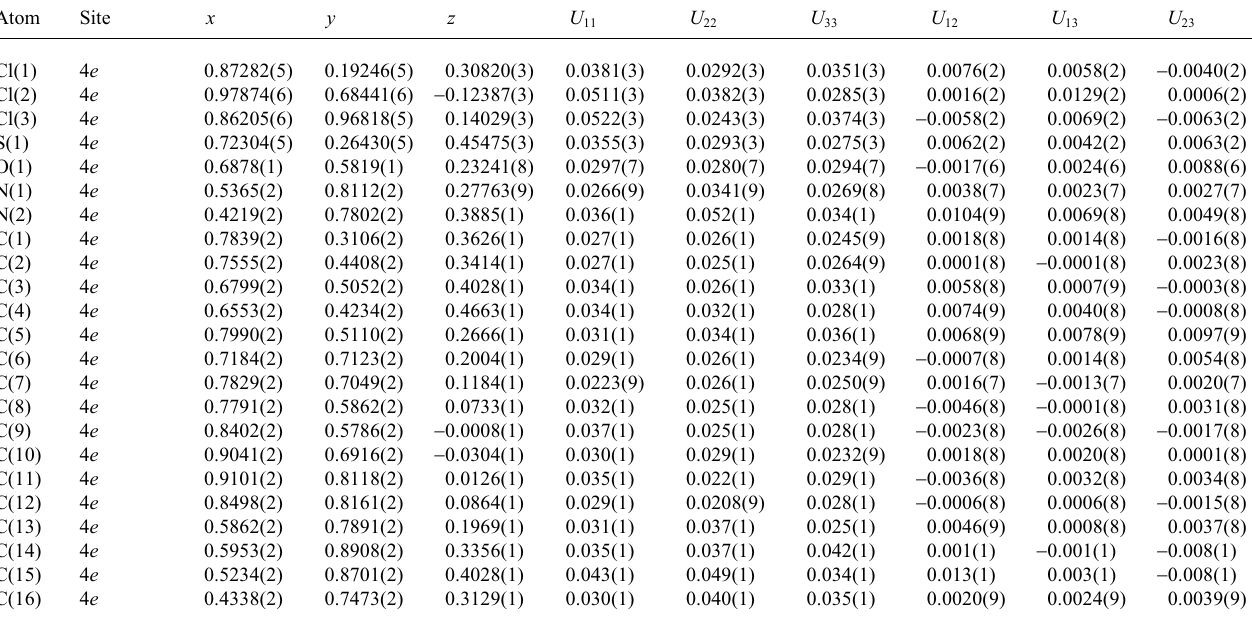
Table 3. Atomic coordinates and displacement parameters (in Å 2 )